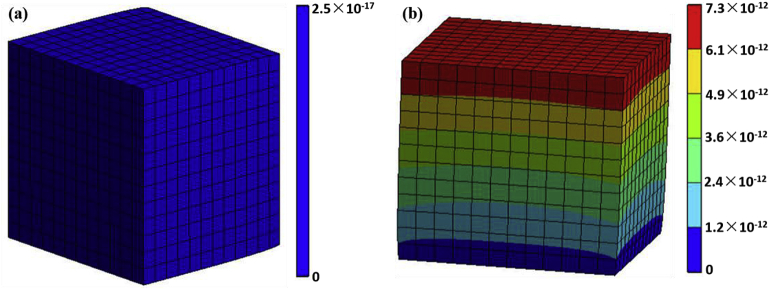
Finite element analysis of total deformation before and after compression of geopolymers with H3PO4/Al2O3 molar ratio of 1.3. (a) 0 MPa; (b) 29 MPa.